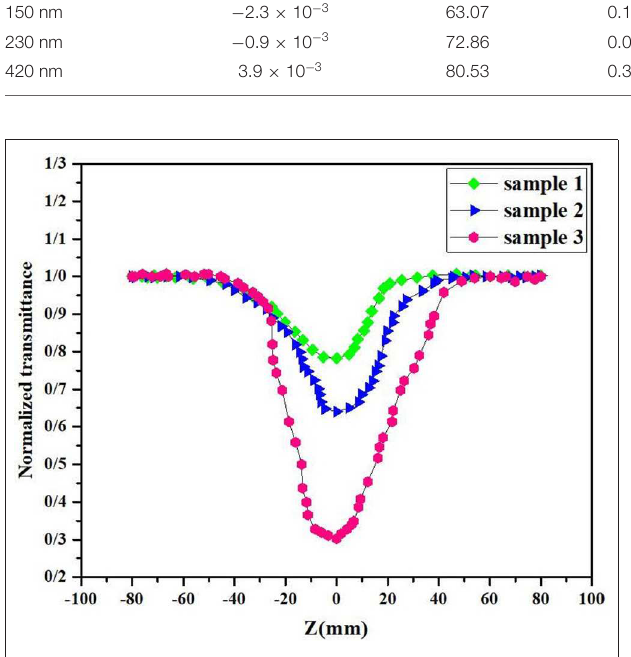
FIGURE 5 | Open aperture Z-scan traces of MoS 2 nanoflakes with various thickness: 150nm (sample 1), 230nm (sample 2), and 420nm (sample 3).